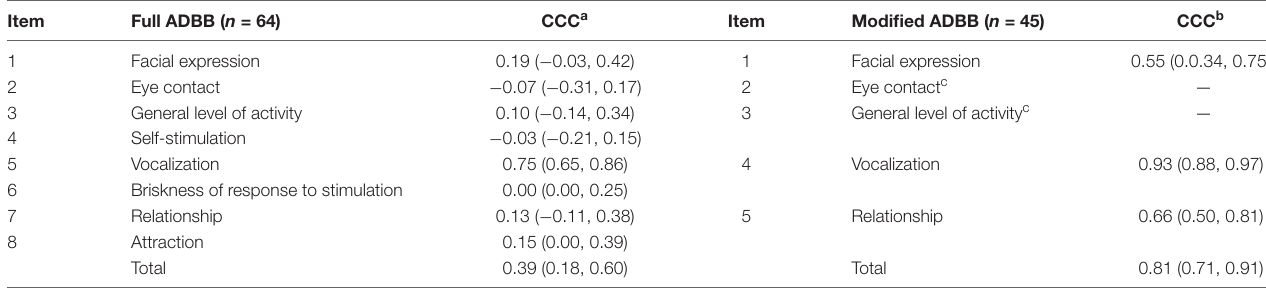
TABLE 3 | Interrater agreement between raters in the full and modified Alarm Distress Baby (ADBB) scale in Nepalese infants.